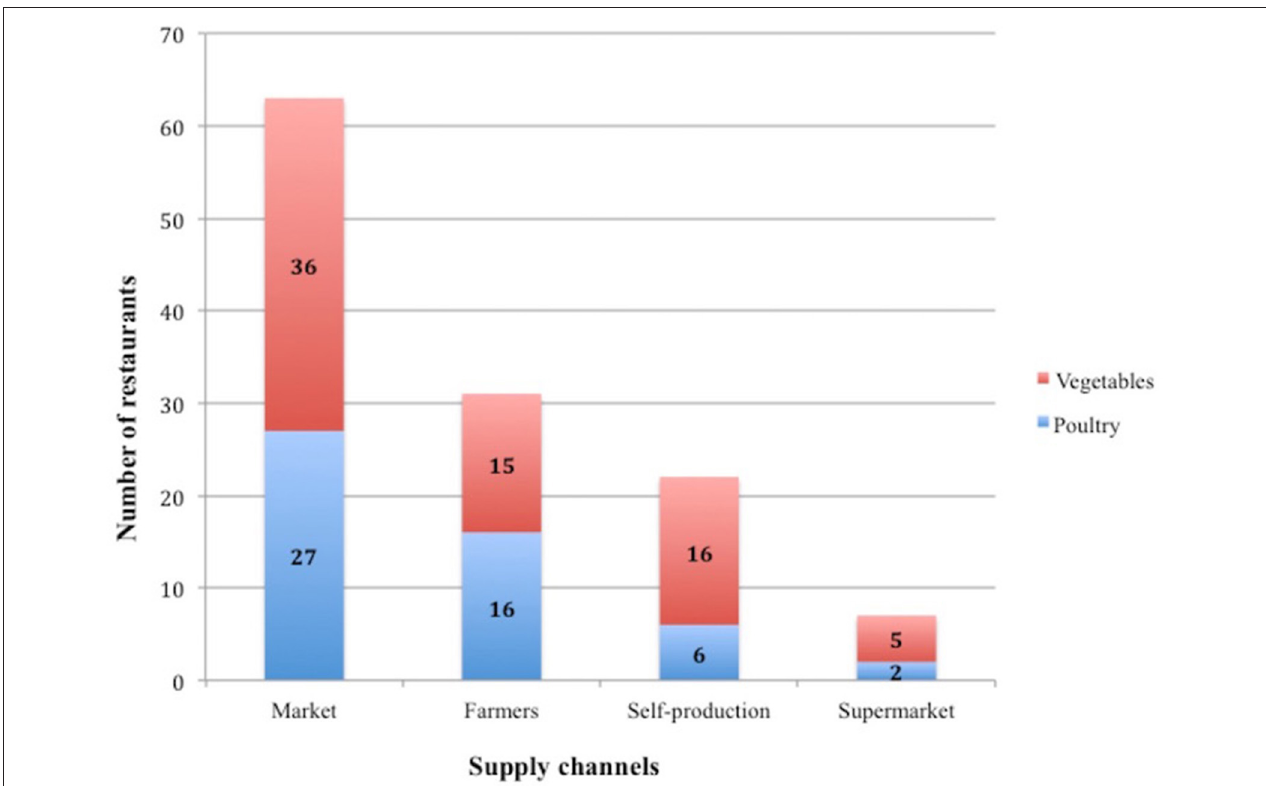
FIGURE 2 | Procurement methods classified according to product category and supply